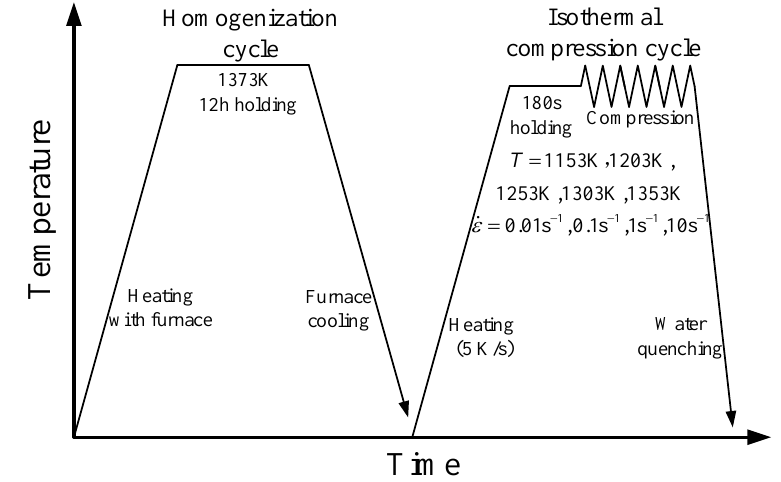
Figure 1. Experimental procedures for the isothermal compression tests of Inconel 718 superalloy.